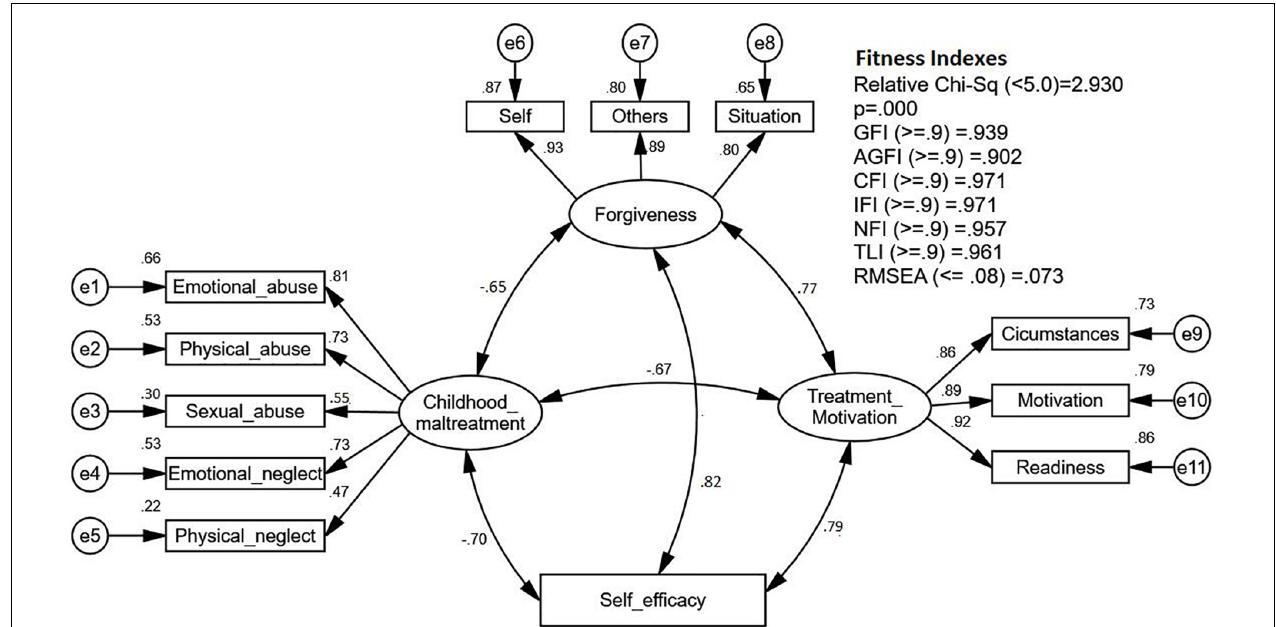
FIGURE 1 | The Results of Confirmatory Factor Analysis (CFA).